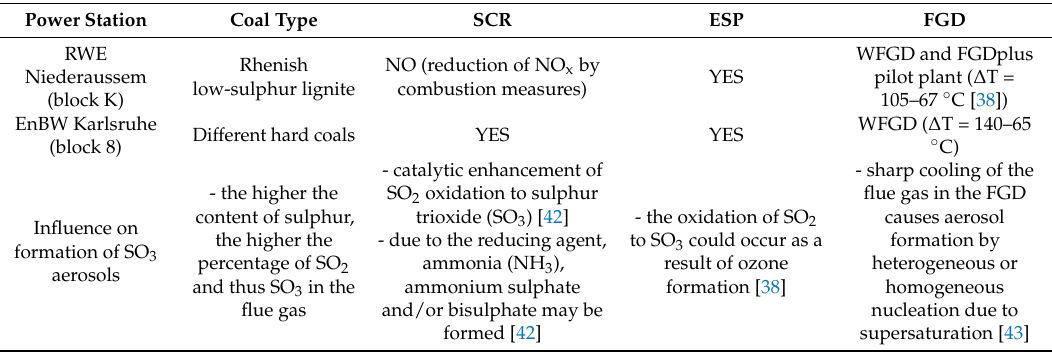
Table 8. Comparison of coal type and flue gas cleaning steps of both power plants and the influence on formation of SO 3 aerosols.